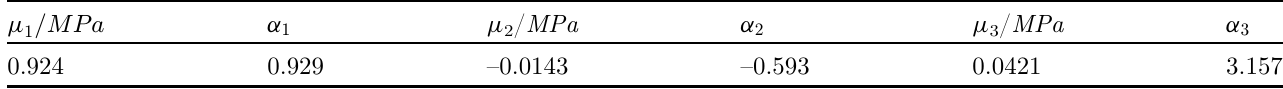
Table 1. Material parameters of the third-order Ogden model after fi tting. = m 1